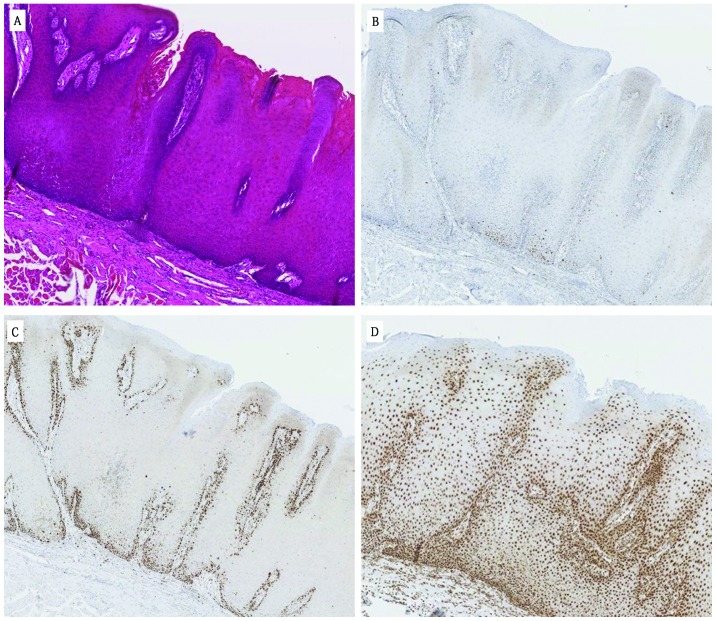
Expression of p53, Ki67 and HuR in oral verrucous lesion (OVL). (A) Basal cells are multi-layered and atypical cells are noted (H&E). However, the number of (B) p53- and (C) Ki67-positive cells are slightly increased and restricted to the lower third of the epithelium. (D) Cytoplasmic HuR expression is more evident than that in the OVH (A–D, magnification ×10). H&E, hematoxylin and eosin; OVH, oral verrucous hyperplasia.